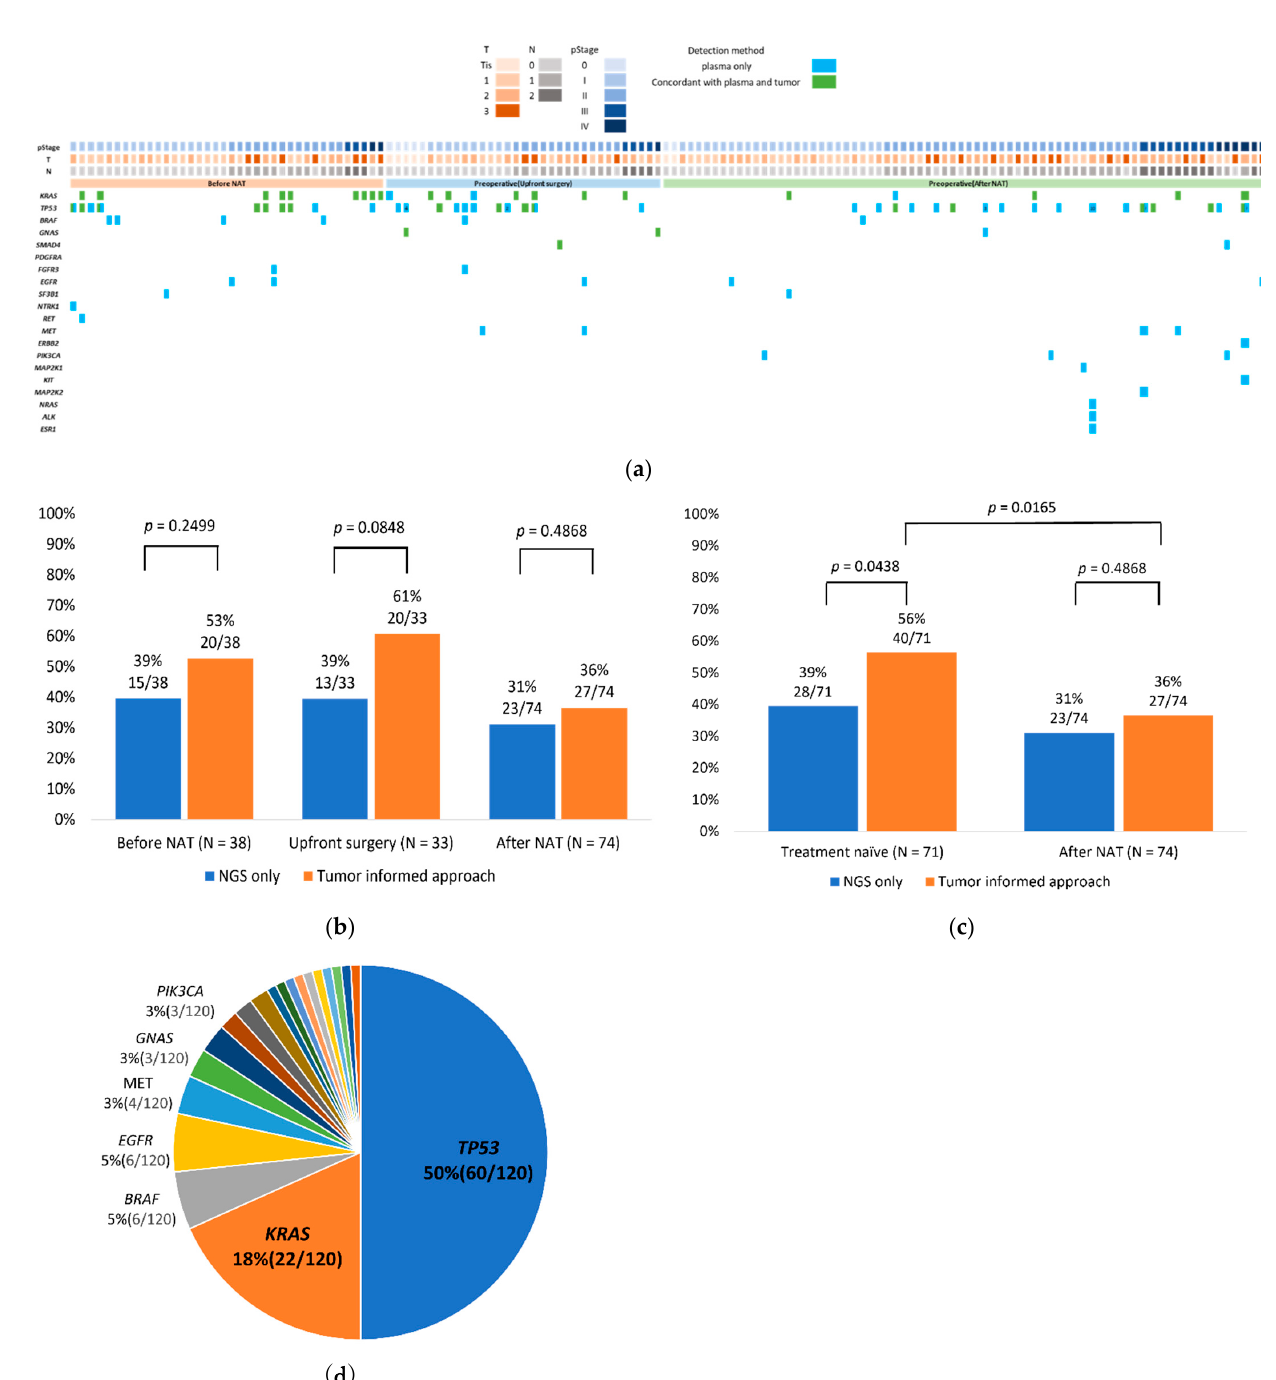
Figure 3. Genomic landscape of ctDNA using tumor-informed approach (TIA) from pancreatic cancer. ( a ) Mutation profiles showing all ctDNA SNVs detected from plasma cfTNA. The clinical characteristics of patients are represented by the tiles at the top of the oncoplot, with details stated in the legend. Mutations are indicated by color in the oncoplot, while numbers signify the number of SNVs for a gene per patient. SNVs that were detected from both plasma and tumor tissue are indicated in green. ( b ) ctDNA detection rates for the two approaches of the three groups. ( c ) ctDNA detection rates for the two approaches of the two groups. The detection rate significantly improved among the treatment-naïve group compared to the after-NAT group ( p = 0.0165). p -values were calculated using Pearson’s chi-square test. ( d ) Overall distribution of mutations calculated as number of mutations per gene over the total 120 tumor-derived mutations, detected using